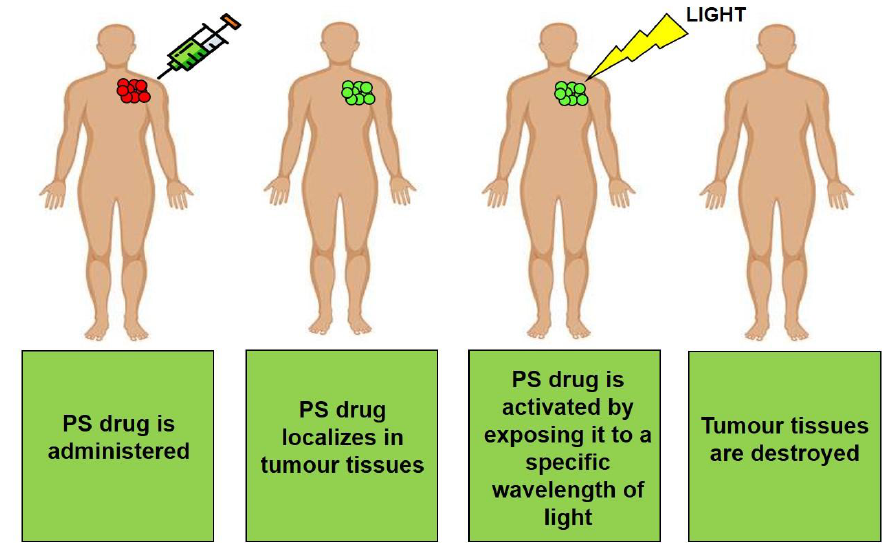
Figure 1. PDT treatment of cancer. The PS drug is administered to a patient and via the bloodstream, it is transported to the tumour site, whereby it localises in tumour cells. Laser light is then applied